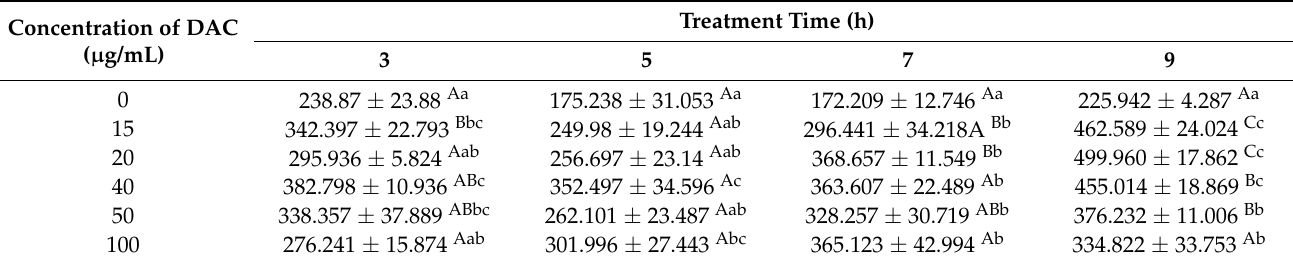
Table 14. The effect of DAC on GSH-Px activity in GMEC